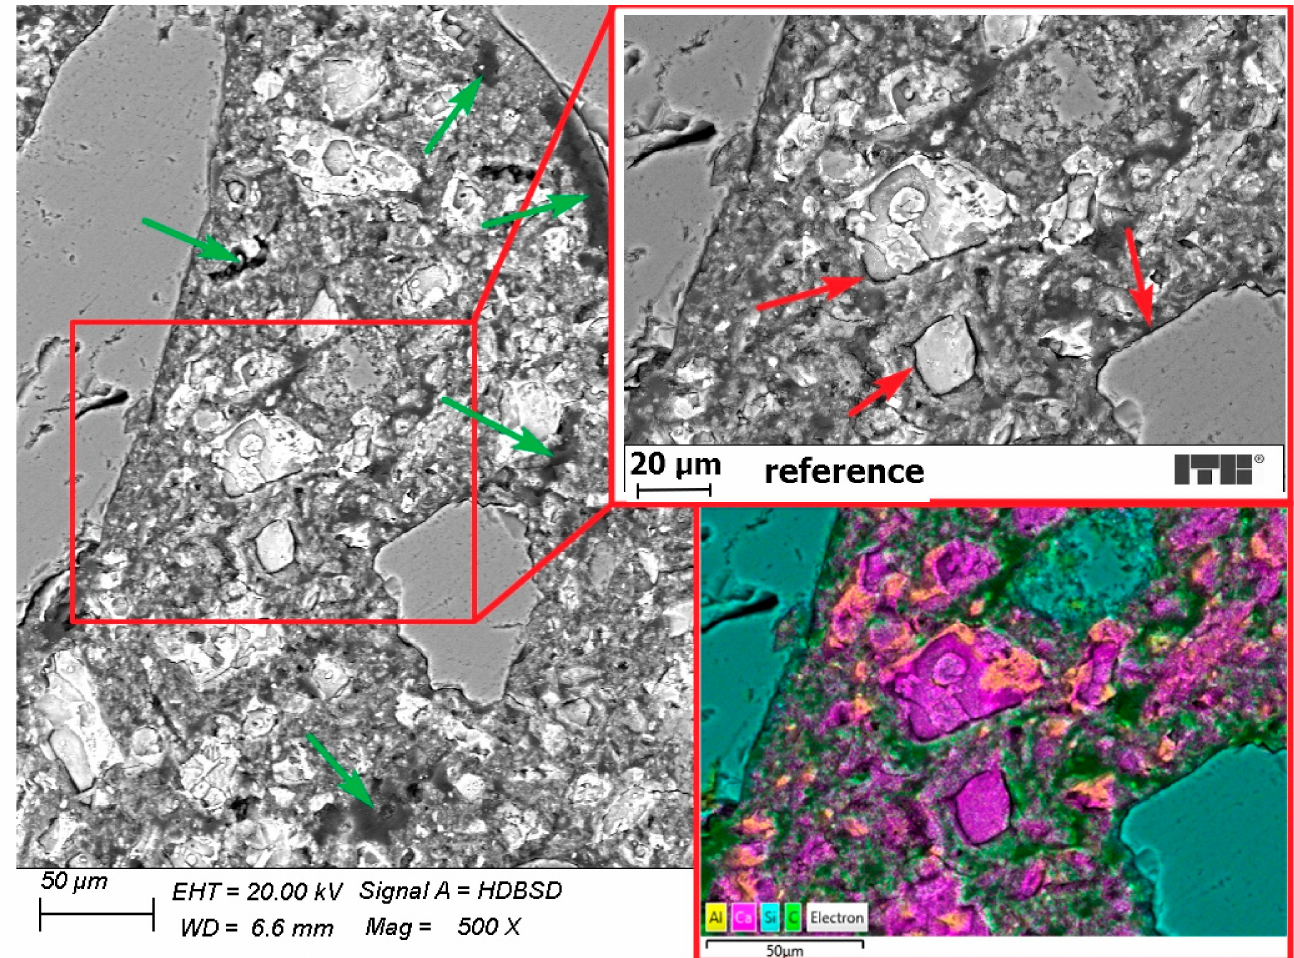
Figure 9. Reference mortar without curing (red arrows—cracks, green arrows—air